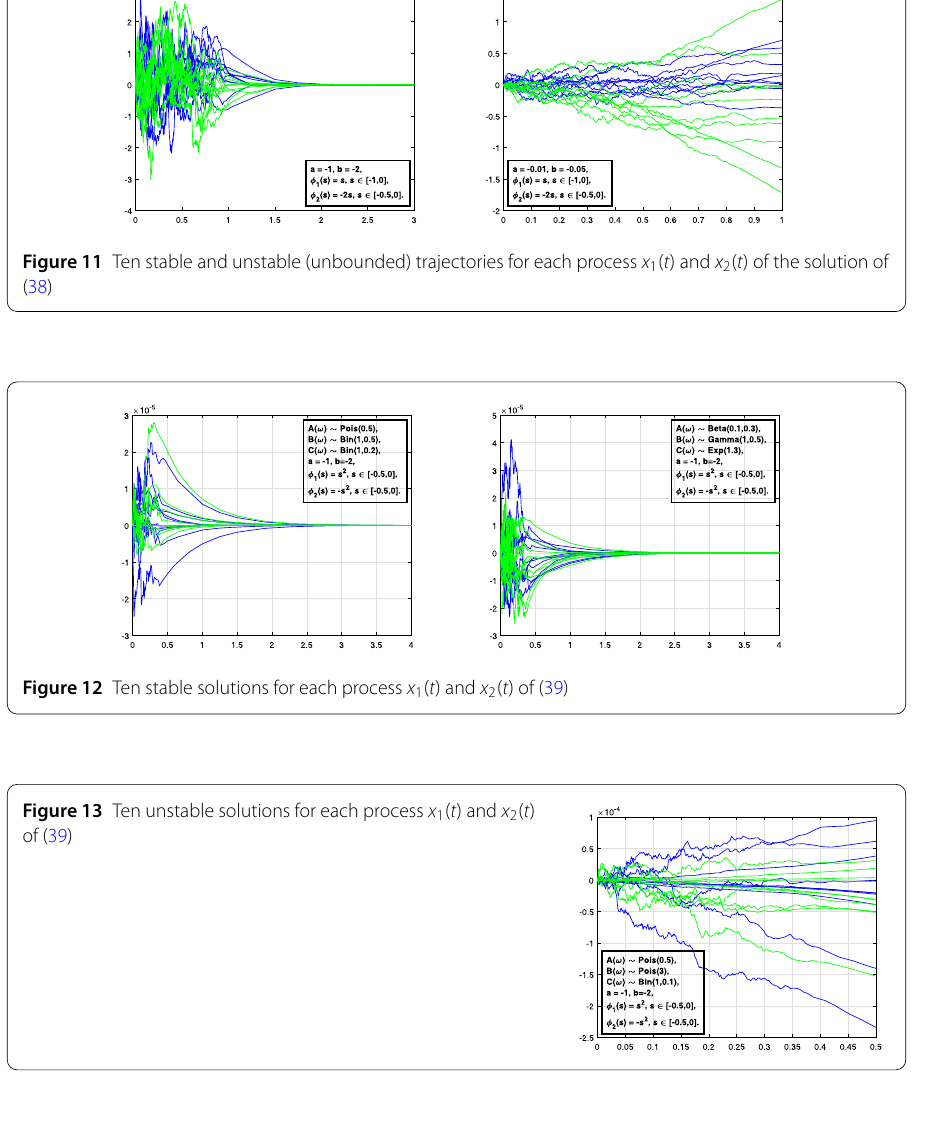
leads to the conditions of asymptotic mean square stability in the form 2 a + (cid:3) A ( ω ) (cid:3) 2 + (cid:3) B ( ω ) (cid:3) 2 < 0 and 2 b + (cid:3) A ( ω ) (cid:3) 2 + (cid:3) C ( ω ) (cid:3) 2 4 Figs. 12, 13 give the numerical simulation of the solutions for different random probability